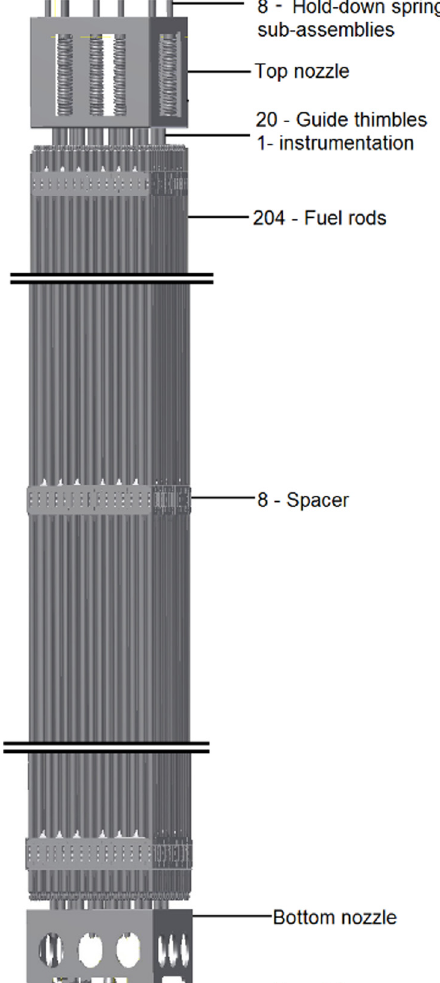
Fig. 1. 3D solid model of CHASNUPP-1 FA.